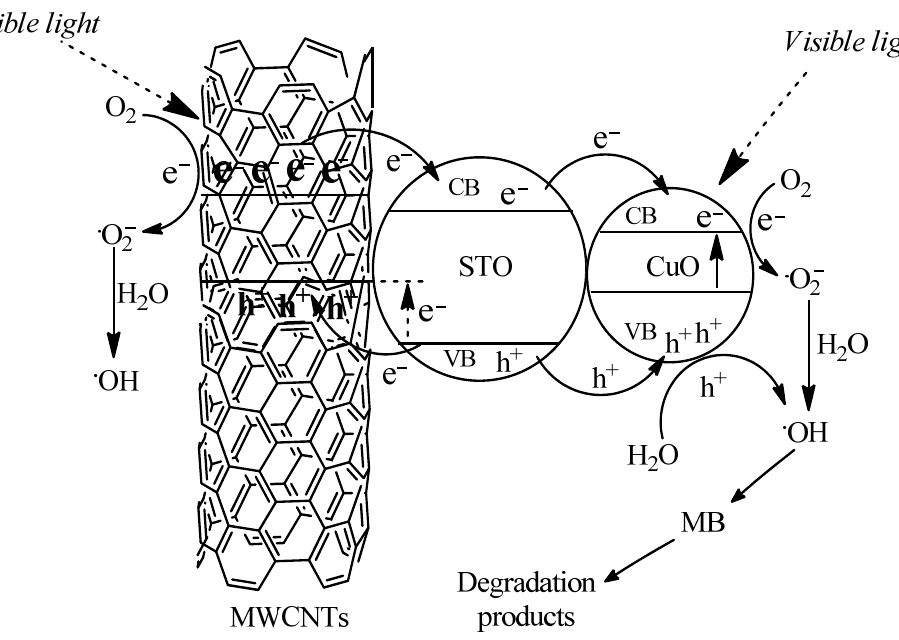
Figure 16. The mechanism for photodegradation of MB by CuO/STO/MWCNTs nanocomposites under visible light irradiation. Table 2. Comparison of photocatalytic degradation efficiency of 5% CuO/STO/MWCNTs nanocom- posites with other competitors and similar